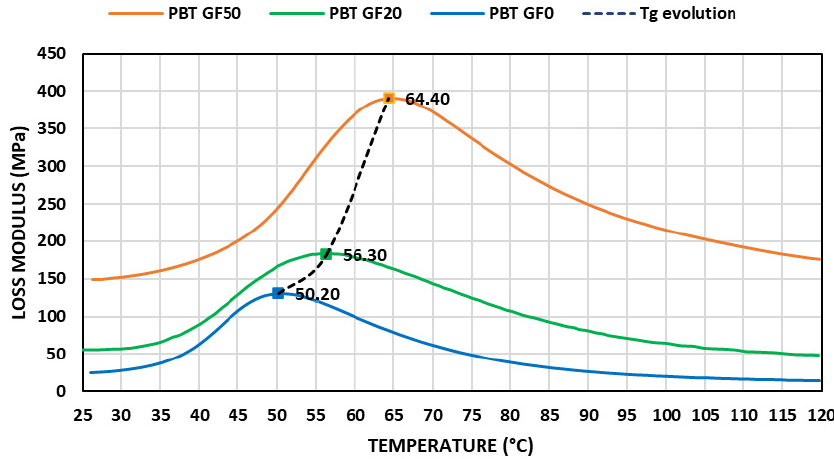
Figure 4. Variation in the loss modulus with temperature (f = 1 Hz).